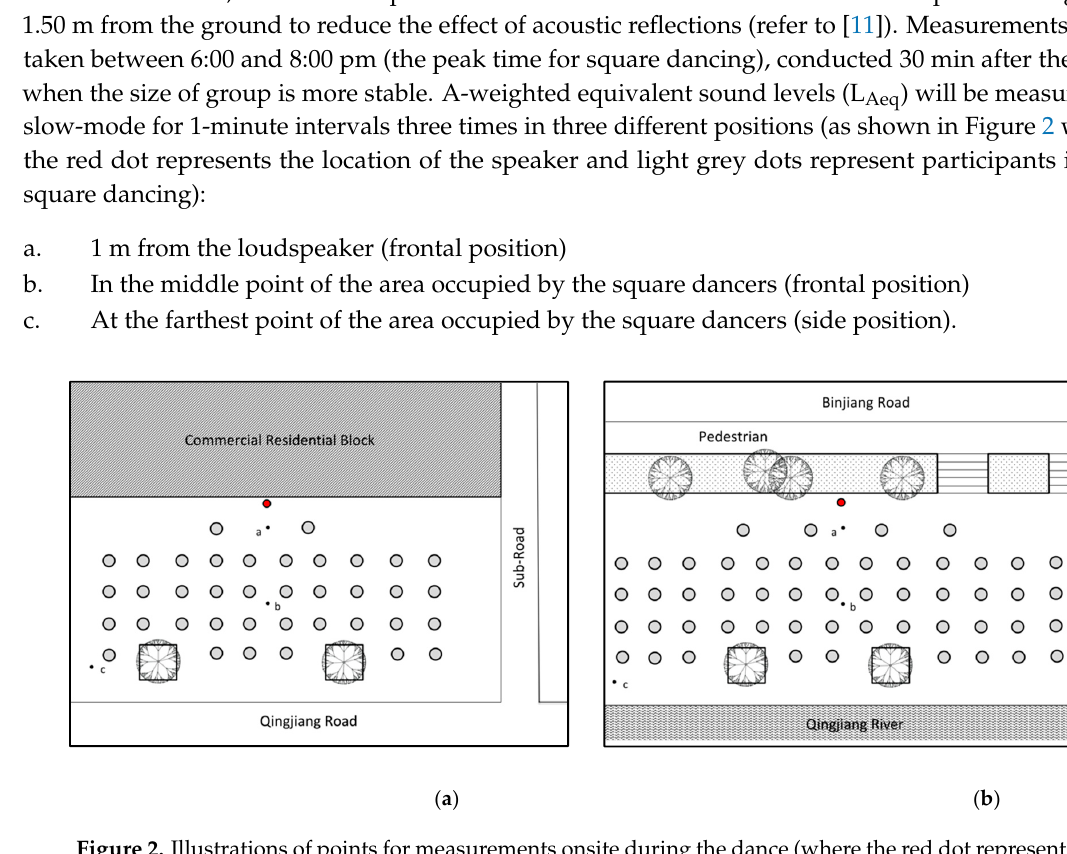
Figure 2. Illustrations of points for measurements onsite during the dance (where the red dot represents the location of the speaker and light grey dots represent participants in the square dancing): ( a ) layout of measuring settings in relation to the speaker at site 1; ( b ) layout of measuring settings in relation to the speaker at site 2.